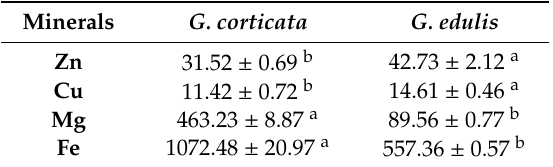
Table 4. Mineral content (mg / kg) in G. corticata and G. edulis